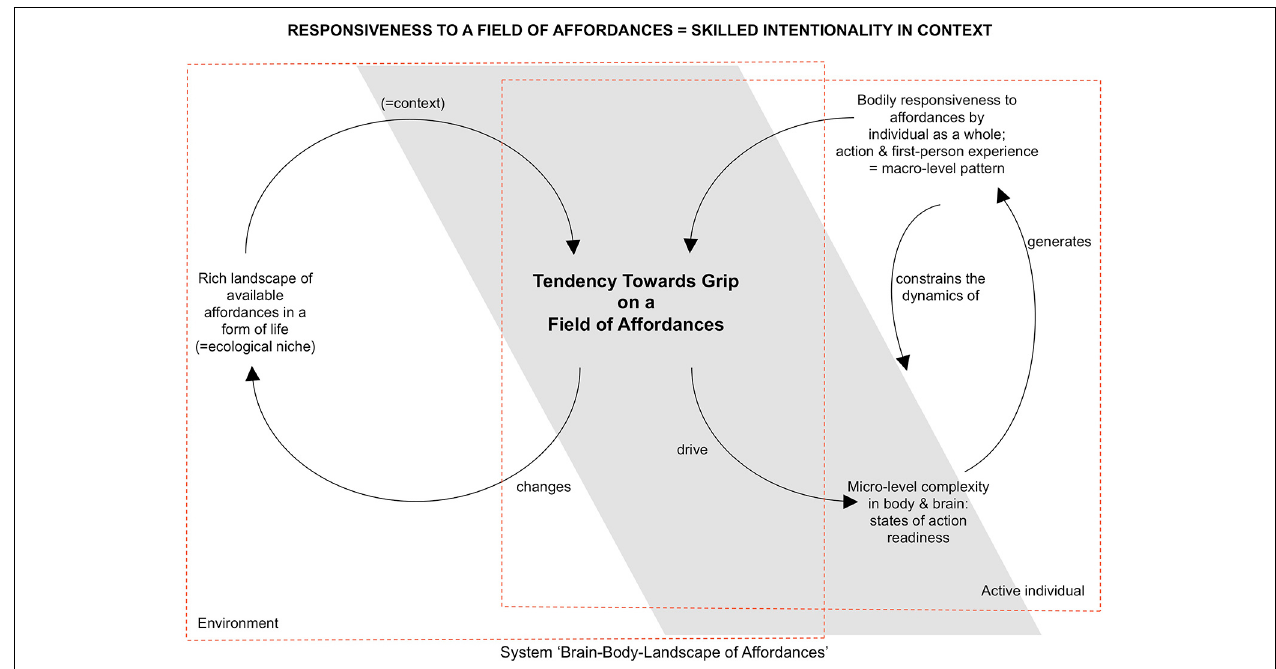
FIGURE 1 | Sketch of the conceptual framework to be refined. Through skilled intentionality one gets a grip on a field of affordances (Rietveld, 2013) (inspired by Chemero, 2003, 2009; Dreyfus, 2007; Thompson, 2007, 2011; Tschacher and Haken, 2007; Rietveld, 2008a,b,